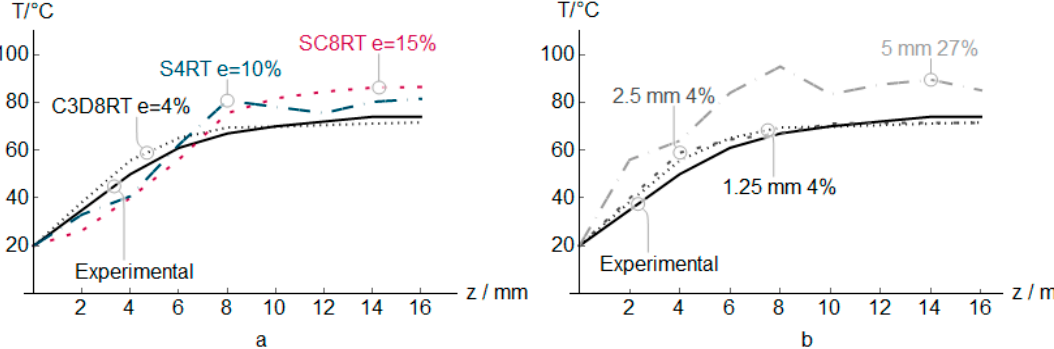
Figure 5. Plane force F xy in PVC incremental forming. Experimental vs. predicted mean values at z positions, and estimation error e for different elements ( a ), and different C3D8RT sizes ( b ).